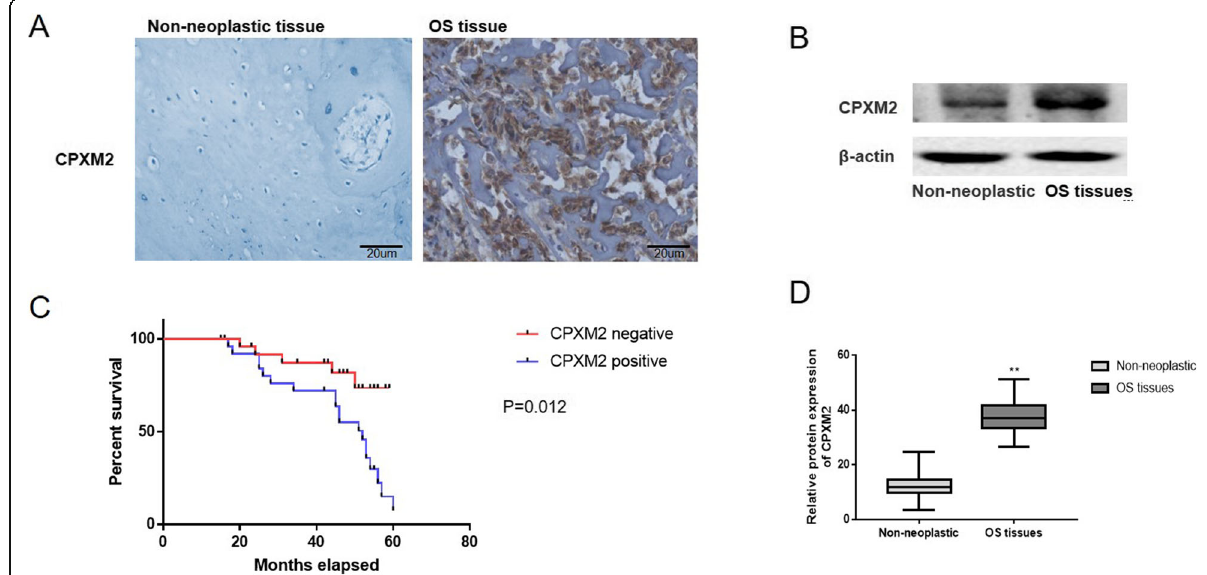
Fig. 2 The expression of CPXM2 in osteosarcoma patients. a Microscopic analysis of CPXM2 protein expression in osteosarcoma tissues versus bone tissues. Scale bars, 20 μ m. b Protein expression of CPXM2 in osteosarcoma tissues versus bone tissues. c Kaplan-Meier Survival Curves and the Log-Rank Test were used in analysis of association between CPXM2 and survival time. d The relative protein expression of CPXM2 in osteosarcoma tissues versus bone tissues. ** P < 0.01 vs. the bone tissues. OS, osteosarcoma; CPXM2, Carboxypeptidase X, M14 family member